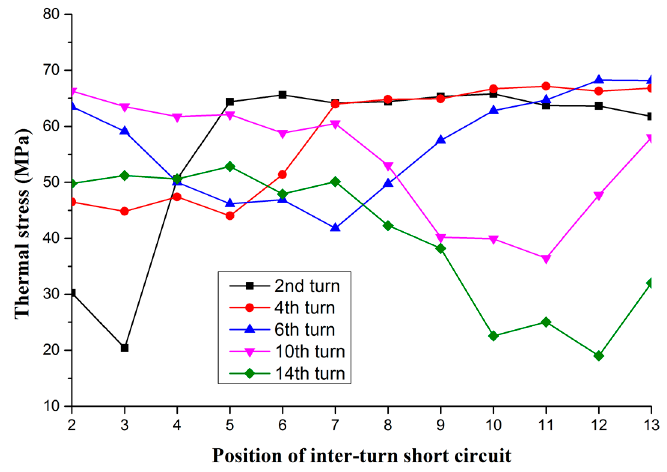
Figure 18. Thermal stress distribution of magnetic pole at different short circuit locations.